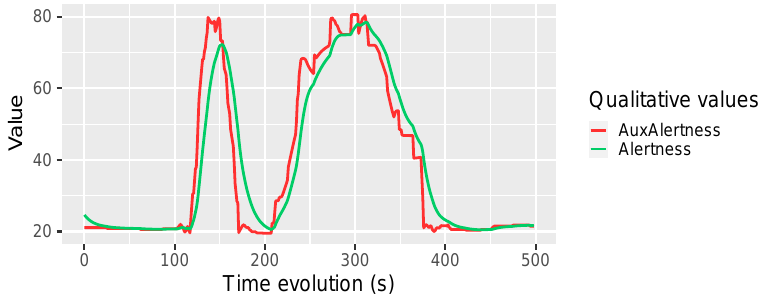
Figure 10. Comparison between the non-filter ALERTNESS and the filter one.